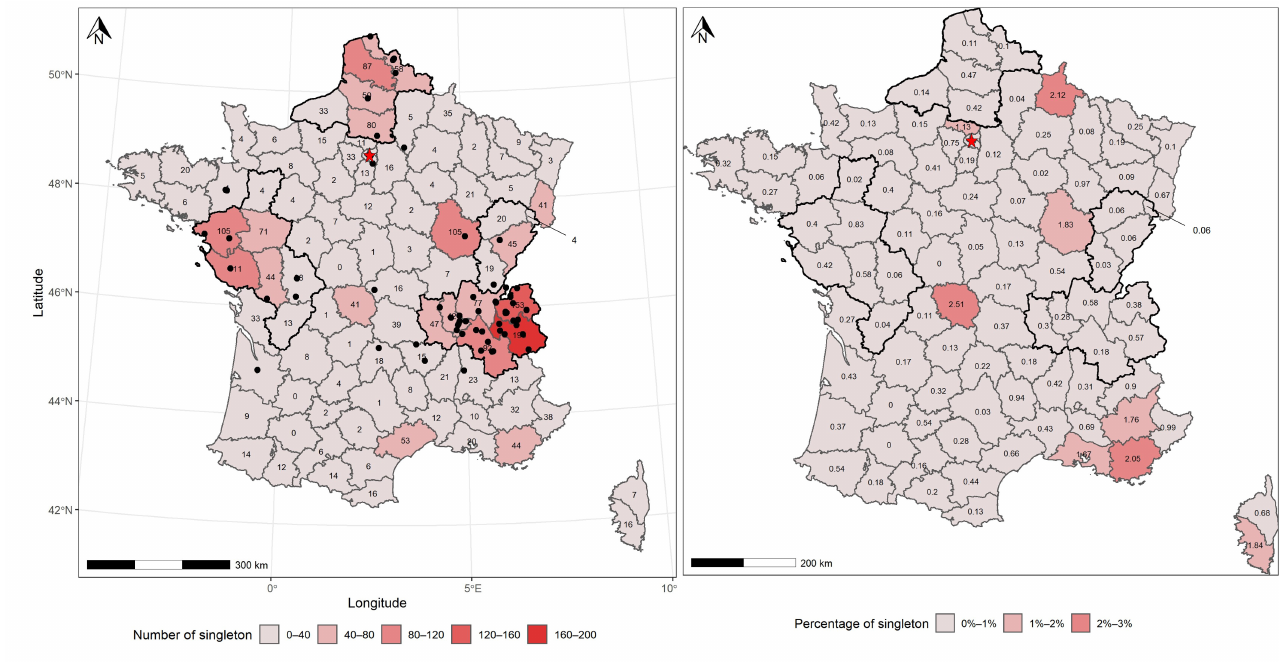
Figure 6. Spatial distribution of taxa represented by one record (singletons) in FongiBase, across French administrative units (departments) using ( A ) the number of singletons and ( B ) the propor- tion of singletons on the total number of records of each department, expressed in percent. Black dots indicate the location of mycological societies. The red star corresponds to the departments of Paris, Hauts-de-Seine, Seine-Saint-Denis and Val-de-Marne, which respectively contain 4, 2, 1, and 2 singletons, corresponding to a proportion of 0.038%, 0.011%, 0.004%, and 0.008% of records in each